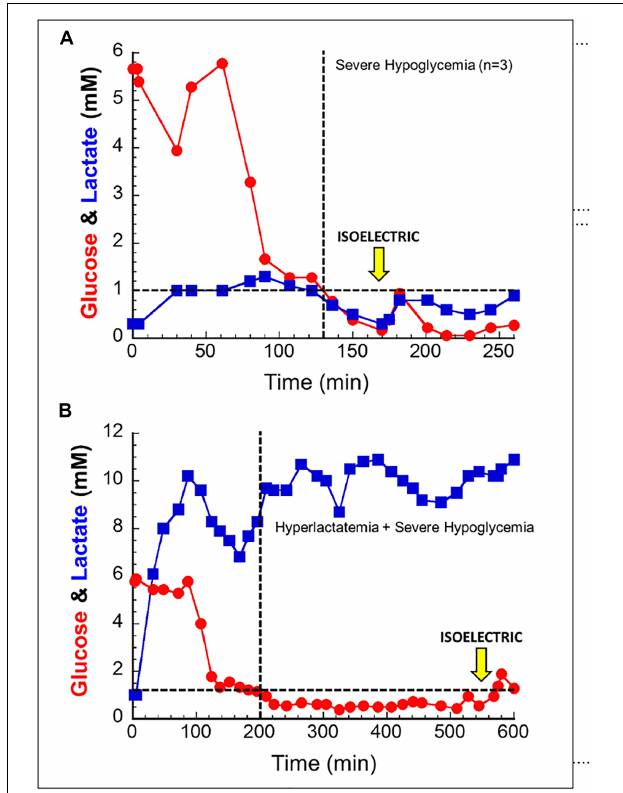
FIGURE 2 | In anesthetized canines, hypoglycemia without a salvage fuel is not well tolerated (A) ; isoelectric brain death is seen around 30 min after hypoglycemia. When lactate is provided as a salvage fuel (B) , brain activity is maintained for 6–8 h after hypoglycemia induction. Note the difference in scale of the X and Y axes of the two figures. Used with permission from Ferguson et al.